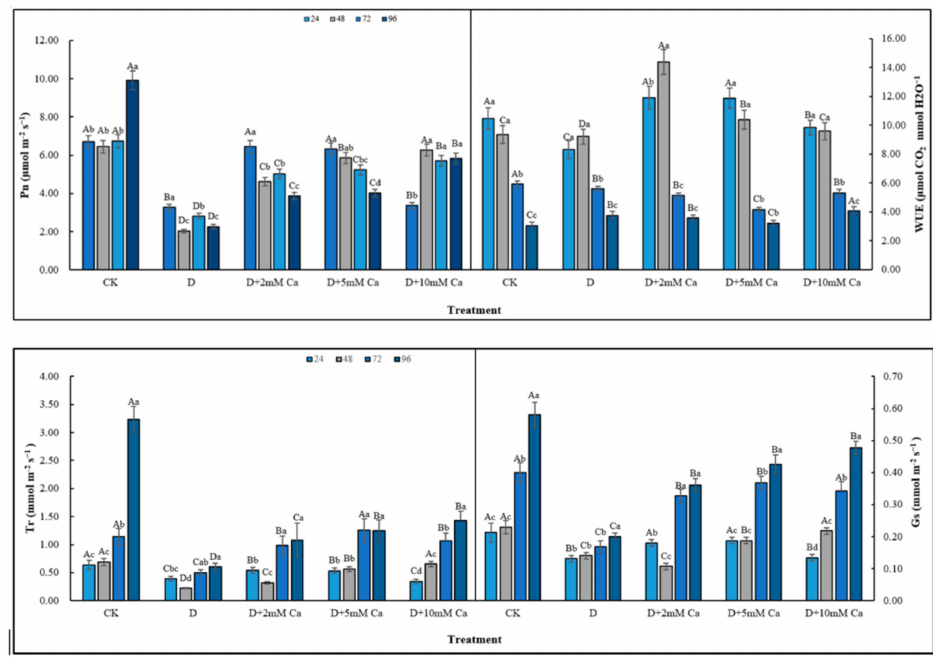
Figure 5. E ff ects of exogenous calcium on the photosynthetic parameters of H . bodinieri under drought stress. Note: Di ff erent capital letters indicate a significant di ff erences between treatments ( p < 0.05) within each sampling time, and lower case letters indicate a significant di ff erence between sampling time ( p < 0.05) within each treatment. The figure data are the average standard error of the three replicates, and the same is